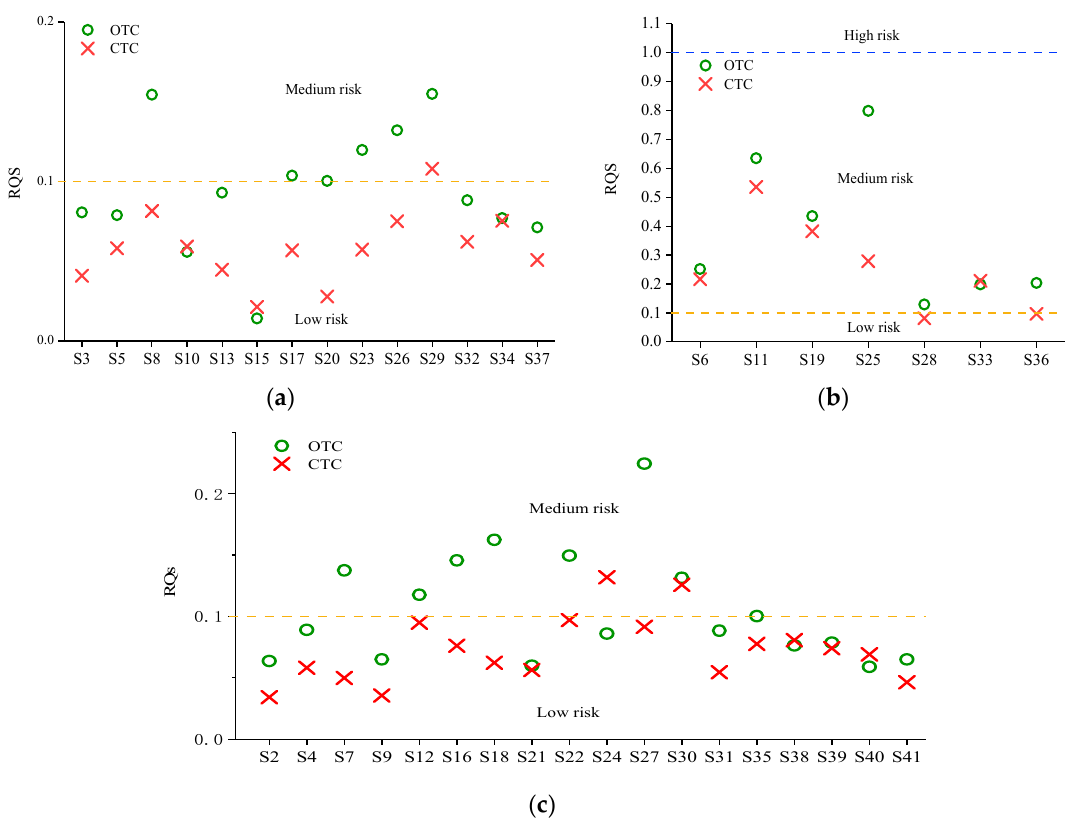
Figure 3. RQs values of OTC and CTC in the ( a ) main streams, ( b ) sewage outlets, and ( c ) tributaries.